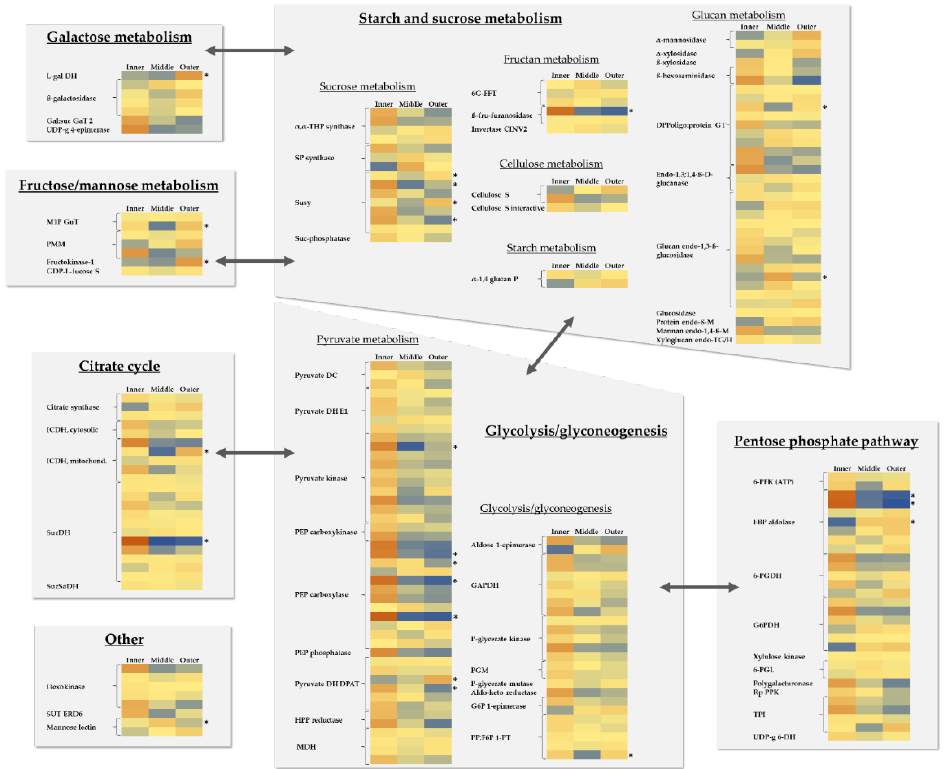
Figure 5. Heatmaps depicting candidate proteins that were identified by the proteome analysis involved in carbohydrate metabolism. Colors represent the normalized relative protein abundance ranging from zero (dark blue) to 300 (dark orange) across the presented data set. Asterisks (*) indicate statistically significant different protein abundances between at least two tissues ( p < 0.05). Related data from protein analysis are presented in Table S3.